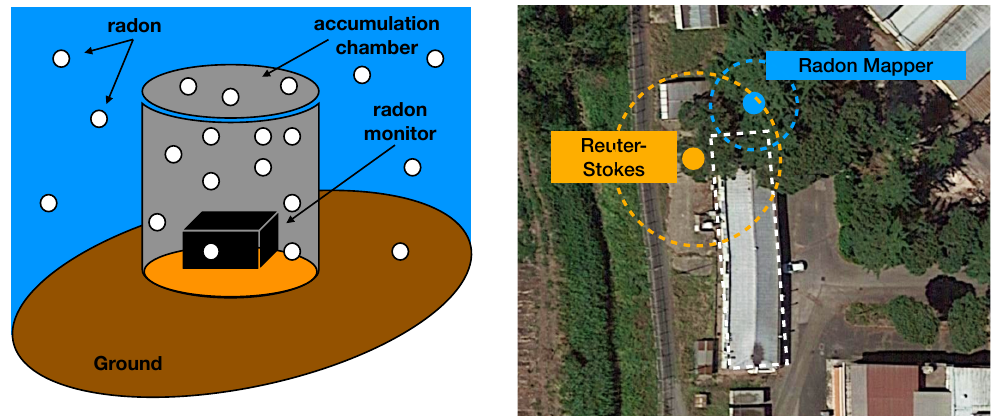
Figure 1. ( Left ) A sketch of the Radon Mapper experimental setup with the accumulation cham- ber. ( Right ) Aerial view of the measurement site with the position of the Reuter–Stokes and the Radon